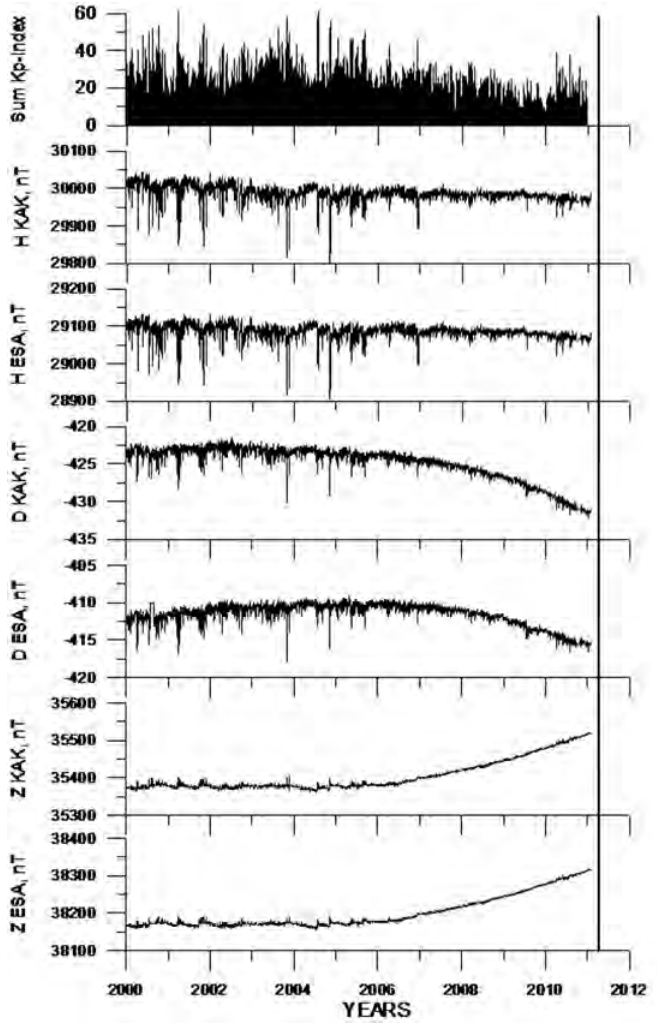
Figure 2. Daily sum of the Kp indices (top panel) and secular variations of the three components of the main geomagnetic field during the period of January 1, 2000 to January 31, 2011. The vertical line marks the earthquake